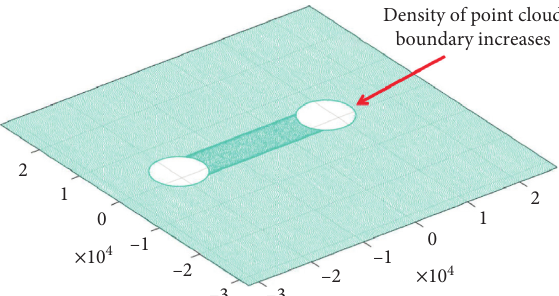
Figure 8: Projection point cloud after the first segmentation.